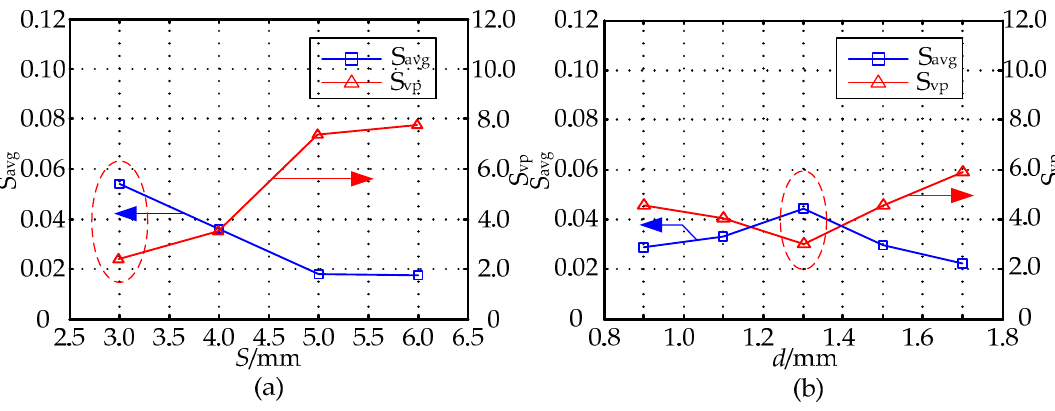
Figure 11. The effect of the MCP geometry on S avg and S vp : ( a ) effect of the S ( D = 20 mm, h = 1 mm, d = 1.5 mm); ( b ) effect of the d ( D = 20 mm, h = 1 mm, S = 3 mm).